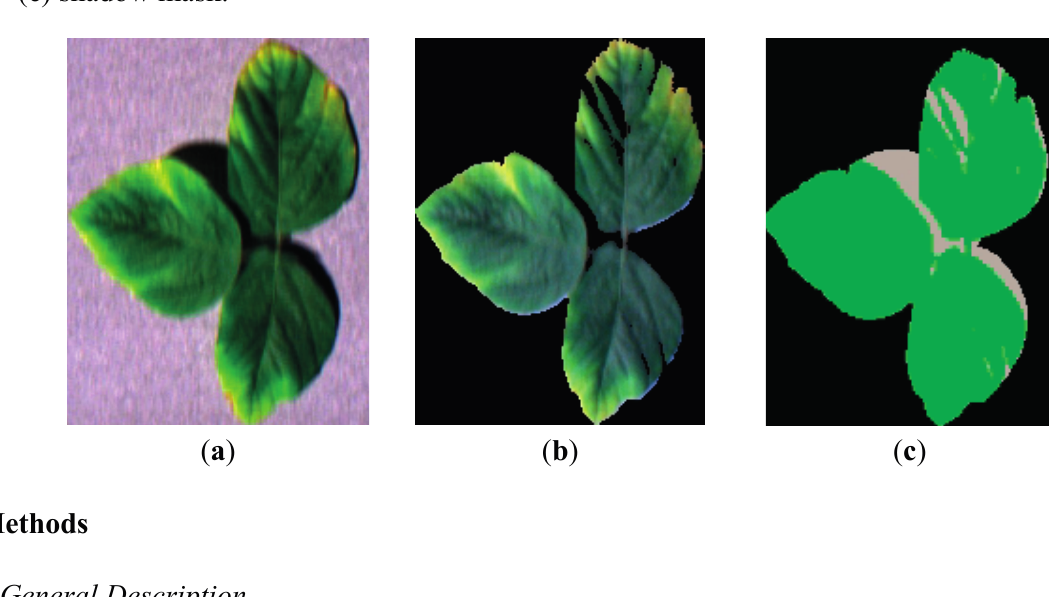
Figure 5. Shadow removal of soybean leaf data. ( a ) Raw data; ( b ) separated leaf; ( c ) shadow